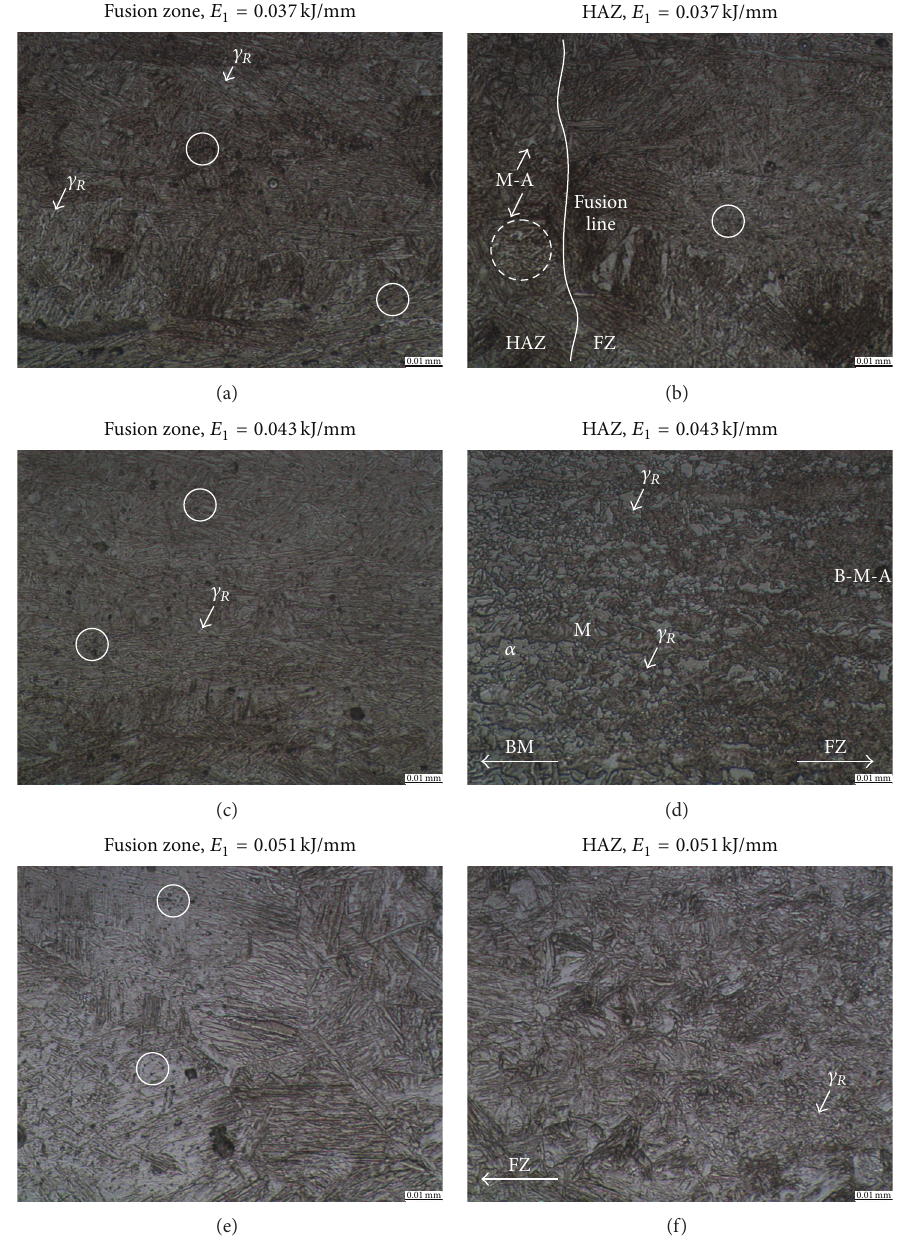
Figure 5: Microstructures of fusion zones (a), (c), and (e) and HAZ (b), (d), and (f) registered for the various heat input values; FZ: fusion zone, HAZ: heat affected zone, BM: base metal, 𝛼 : ferrite, 𝛾 𝑅 : retained austenite, M-A: martensitic-austenitic constituents, M: martensite, B-M-A: bainitic-martensitic-austenitic regions; white circles indicate nonmetallic